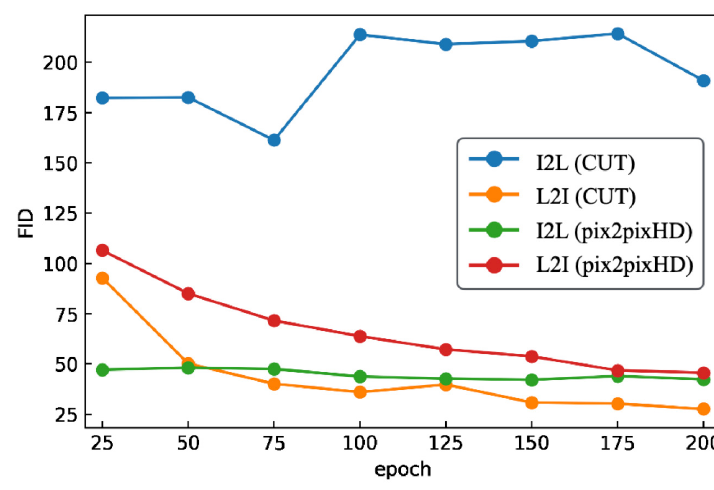
Figure 7. Time-series FID trends for the respective GANs in Cityscapes.